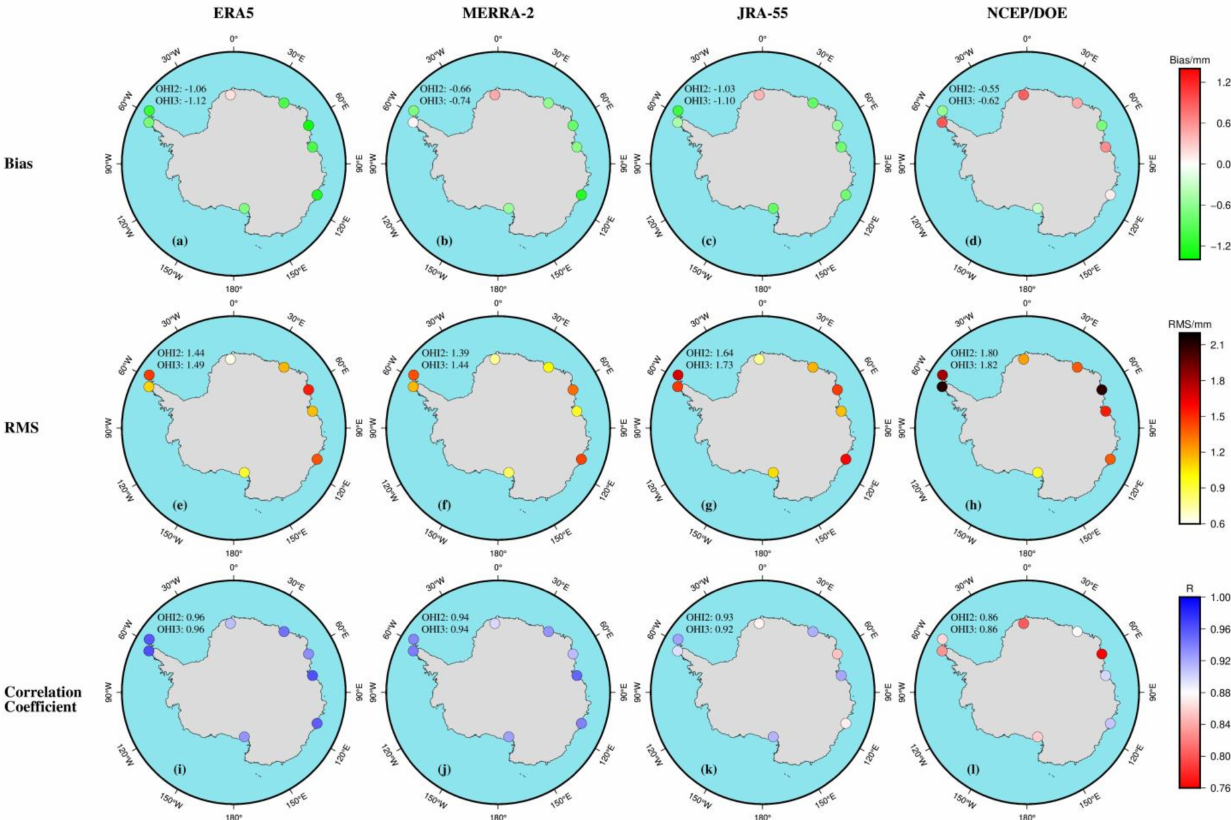
Figure 6. Spatial distributions of the (top) bias, (middle) RMS and (bottom) correlation coefficient of the PWV between ( a , e , i ) ERA5 and GNSS, ( b , f , j ) MERRA-2 and GNSS, ( c , g , k ) JRA-55 and GNSS and ( d , h , l ) NCEP/DOE and GNSS in Antarctica from 2001 to